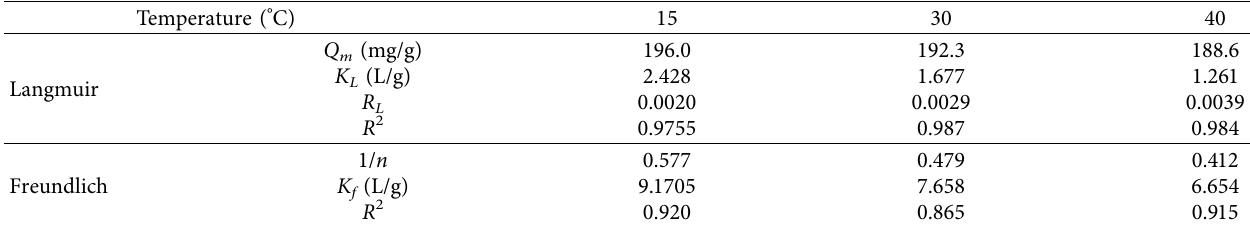
Table 5: Isotherm model constants for batch adsorption of Murexide.